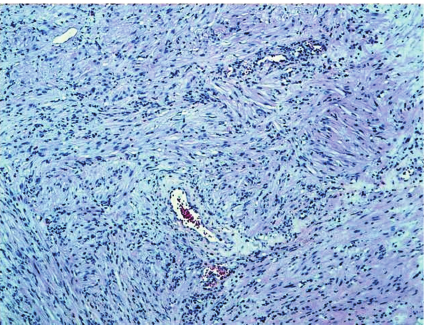
Figure 1: Benign tumoral proliferation organized in fascicles.